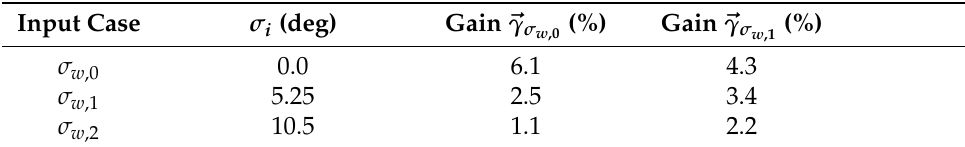
Table 3. Gains per input condition case for the deterministic yaw angle set ( (cid:126) γ σ angle set ( (cid:126) γ σ w ,1